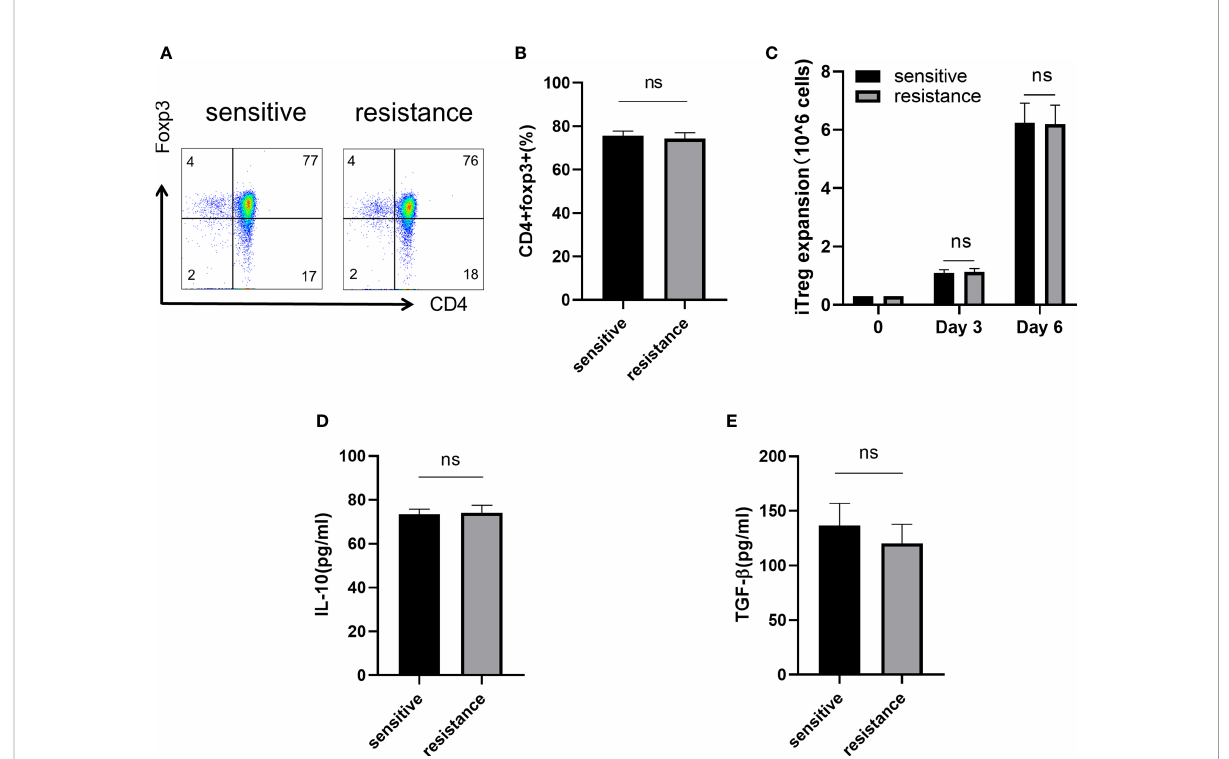
FIGURE 2 Naive T cells regulated iTreg induction and function in vitro. Representative fl ow plot (A) and the frequency (B) of Foxp3 expression in iTregs of sensitive and resistant patients. The expansion ability of iTregs. (C) The expression of anti-in fl ammatory cytokines including IL-10 (D) and TGF- b (E) from the serum was evaluated through ELISA. The bar shows the mean ± SEM of the levels of indicated proteins (sensitive patients n=4; resistant patients n=4). ns, non-signi fi